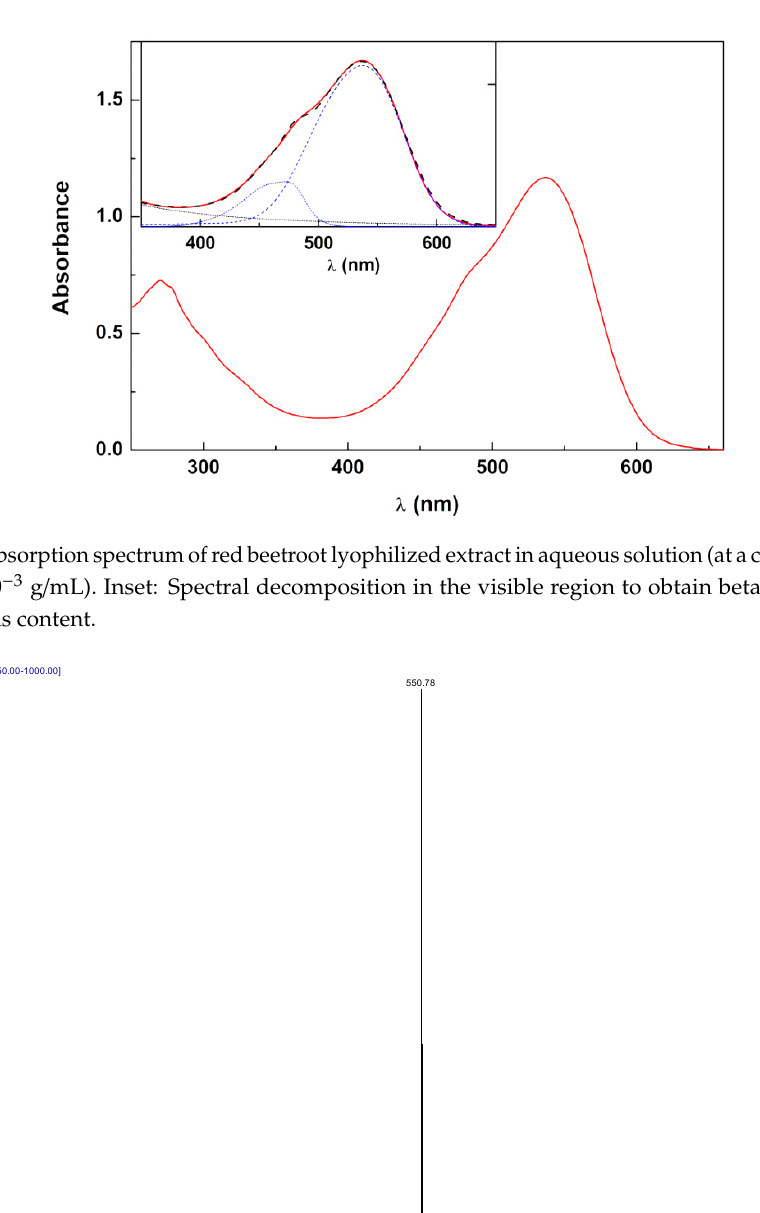
Figure 3. Low resolution mass spectrum acquired in positive ionization mode (ESI) of red beetroot lyophilized extract with peaks at 550.78 (100.00 %) and 551.78 m/z (39.50%).